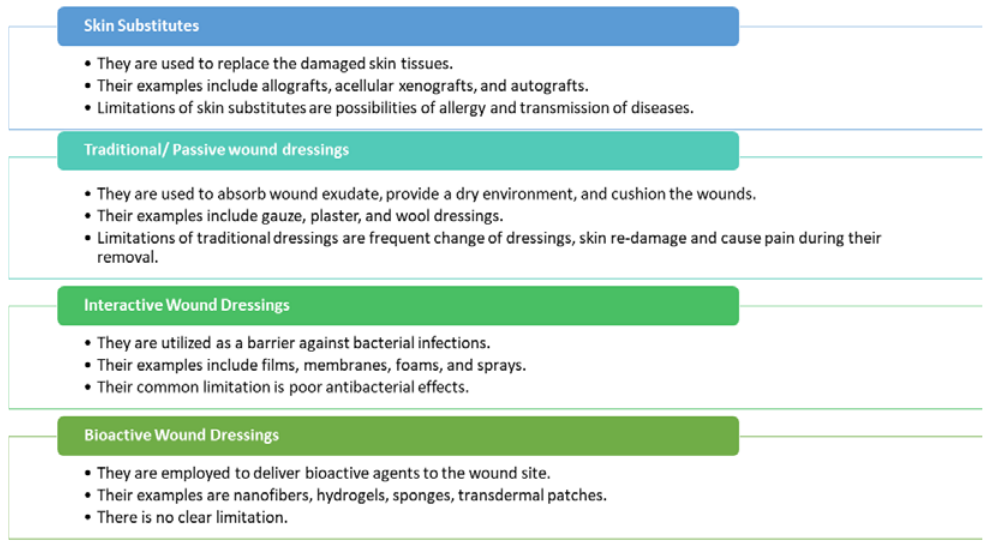
Figure 1. Classification of wound dressings.